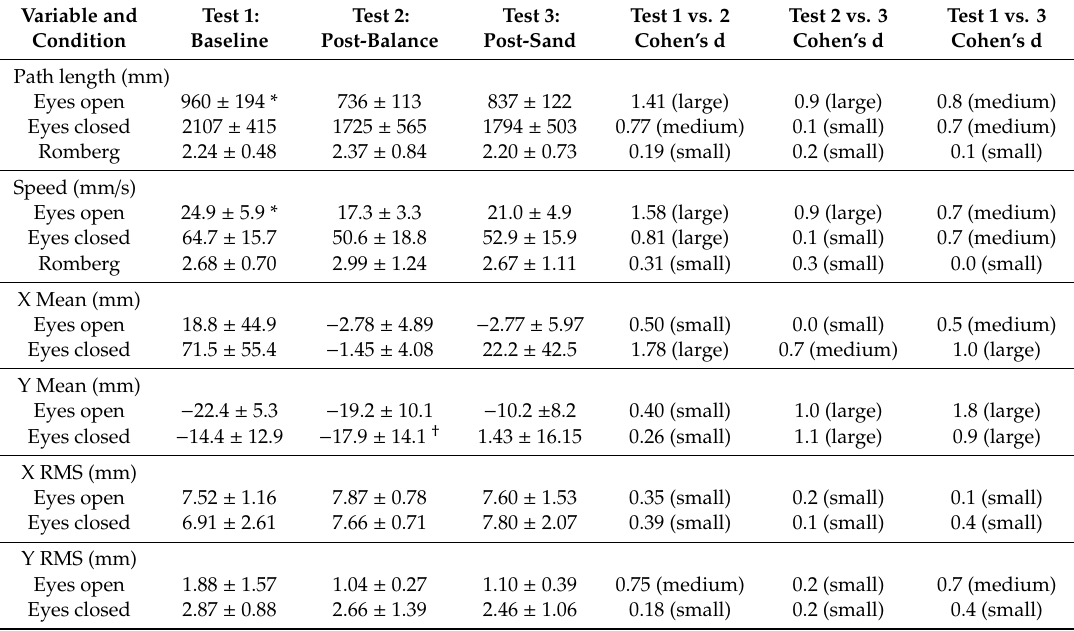
Table 2. Dominant monopedal stance. Parameters expressed as mean ± SD.